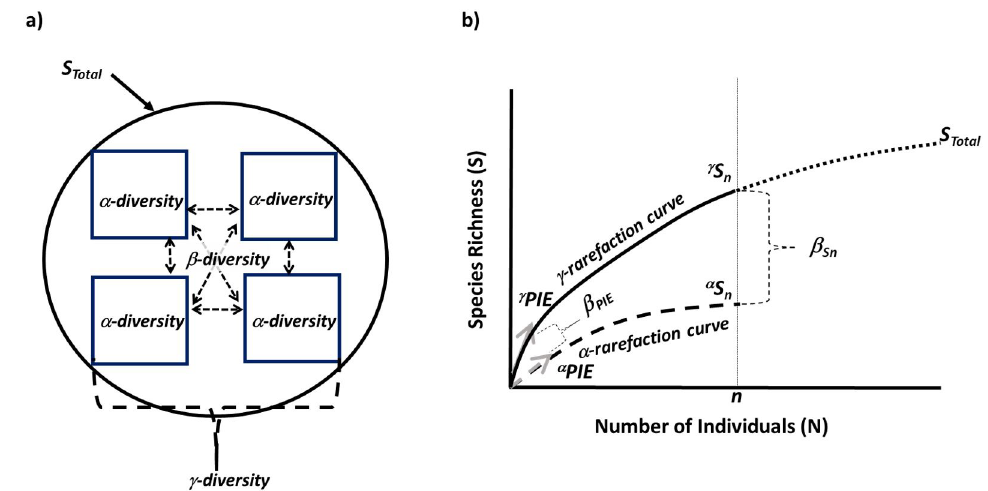
Figure 1. (a) Overview of a sampling scheme appropriate for applying the analytical approach outlined in this paper. The circle represents a hypothetical island, and each of the four squares represents individual sampling plots from which α-diversity metrics can be derived. The addition of all of the individuals sampled in all of the plots allows the calculation of γ-diversity metrics, while the differences among the α-diversity plots is β-diversity. S represents the total number total of species on the island, including those that were not observed in any of the sampled plots. (b) Illustration of how these diversity indices can be visualized graphically from individual-based rarefaction curves that plot species richness ( S ) against the numbers of individuals ( N ) across scales. The γ-rarefaction curve (solid line) is derived by combining all individuals from all plots measured on a given island and randomizing individuals to generate the curve. From this curve, the dashed line allows us to visualize the total number of species on the island including up to S . We can also visualize: (i) the numbers total of species expected from a given number of individuals ( n ), γS (where the vertical dashed line at n intersects the solid n curve); (ii) the probability of interspecific encounter (PIE), which represents the slope at the base of the rarefaction curve, γ PIE (solid grey arrow). The α-rarefaction curve (dashed line) is derived by randomizing individuals from a single plot, and similar parameters can be derived — α S (vertical dashed line intersects the dashed curve at n individuals) and α PIE n (dashed grey arrow). The ratio between the γ− and α-rarefaction curves provides estimates of β-diversity that indicate the degree of intraspecific aggregation on the island. Note, in text, we advocate converting PIE values into effective numbers of species ( S ), but only illustrate PIE in the figure as it is not straightforward to illustrate S on these PIE PIE